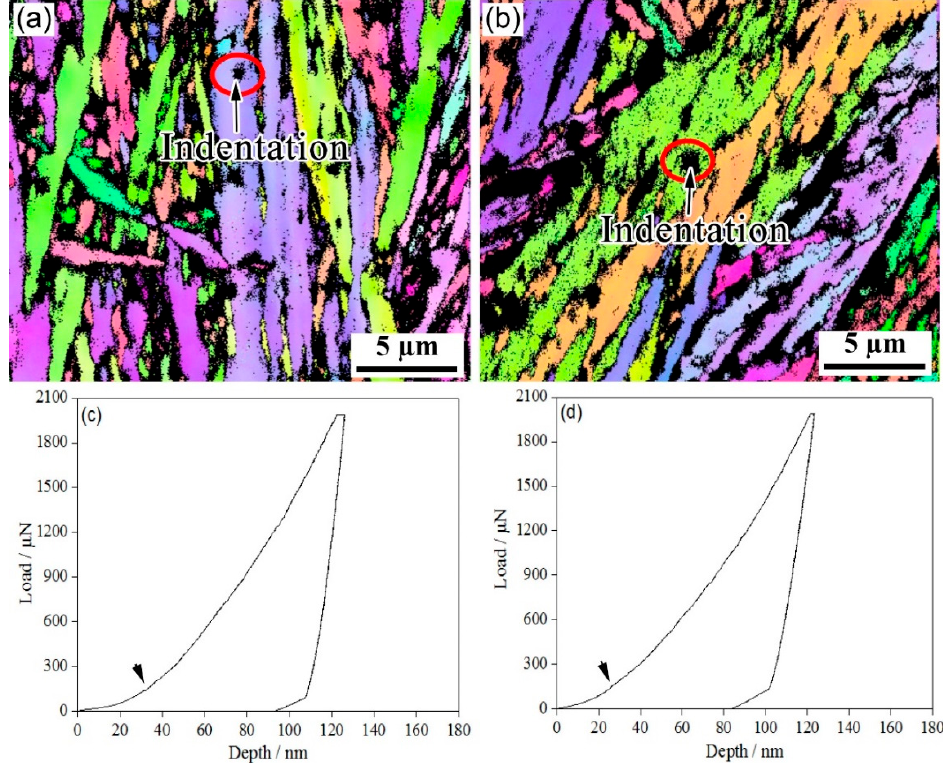
Figure 5. Nanoindentation of bainite sheaf in the investigated steel for ( a , c ) one-step and ( b , d ) two-step techniques. ( a , b ) BCC structures and ( c , d ) representative load–displacement plots.